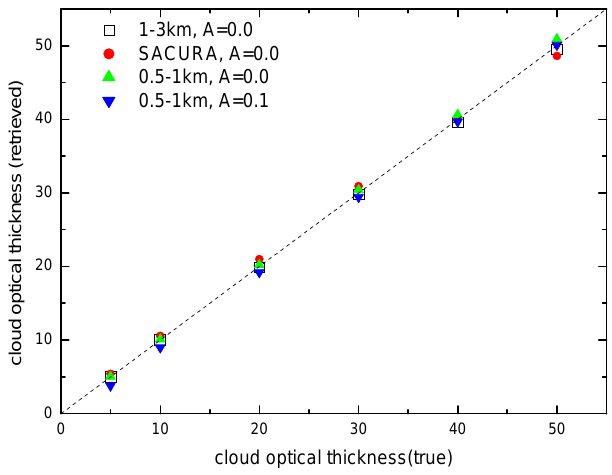
Fig. 5. The correlation plot of the retrieved versus true COT. Circles give the results of the retrieval based on the semi-analytical cloud retrieval algorithm for a homogeneous cloud (the first guess solution for the optimal estimation approach). Squares correspond to the case of a cloud positioned between 1–3km and triangles correspond to the cloud positioned between 0.5–1km ( for the assumed underlying surface albedo 0.0 and 0.1) in the retrieval process. The true underlying albedo was equal to 0.0, SZA=60 ◦ , VZA=0 ◦ . Fig. 6. The MODIS/TERRA browse image of the studied cloud scene (31 May 2001, 16:55UTC). The cross signifies the position of the ARM site (36.61 ◦ N, 97.49 ◦ W).